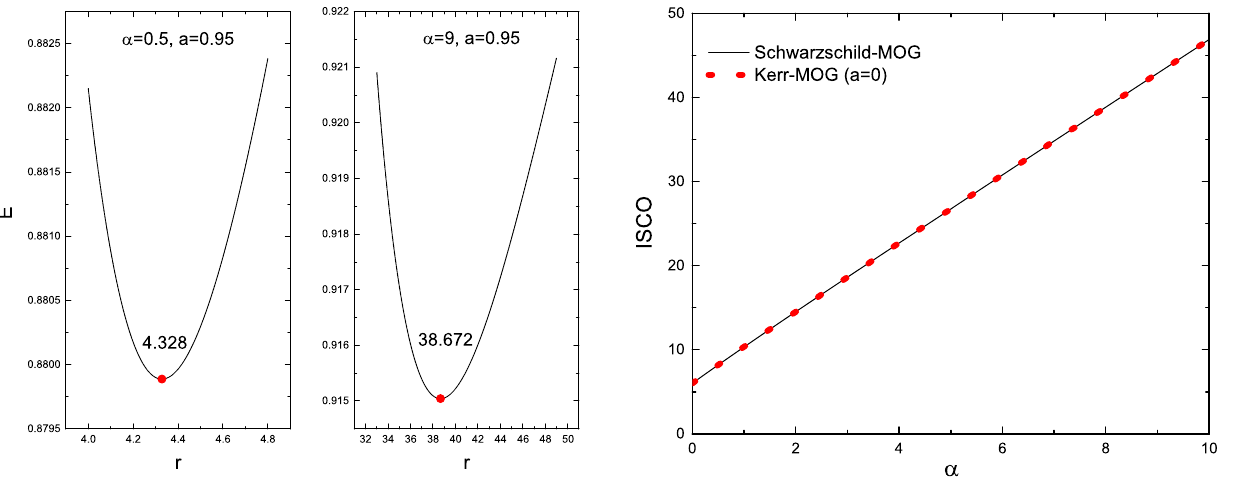
Fig. 9 Comparing ISCOs of the Schwarzschild-MOG and Kerr black holes when a = 0, two values coincide for all values of α